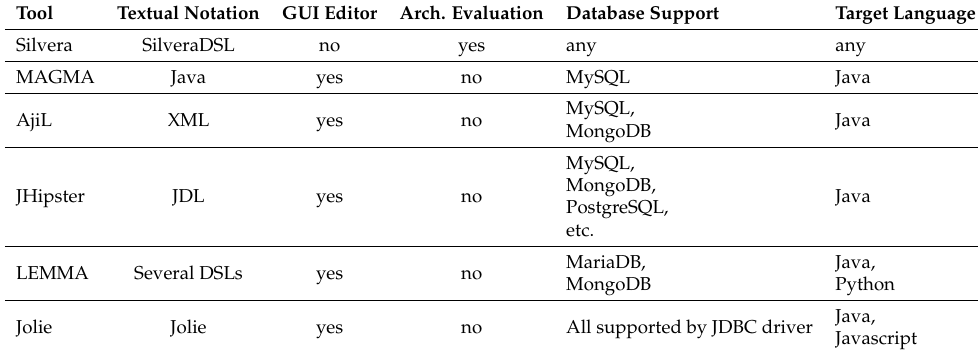
Table 3. Comparison of available features in Silvera with other tools.